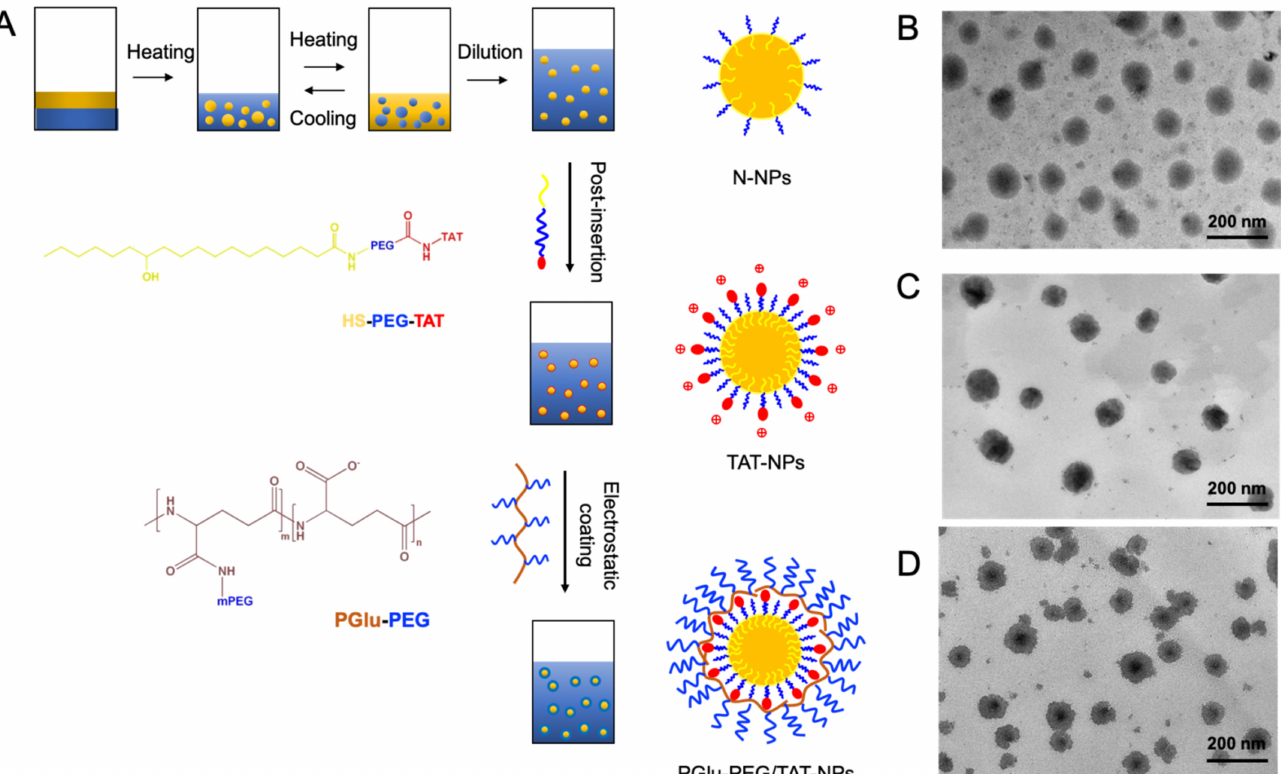
Figure 1. ( A ) Schematic illustration of preparation of DSF-loaded nanoparticles and corresponding structures. N-NPs were prepared by phase-inversion method. TAT-NPs were obtained by post-insertion of HS-PEG-TAT due to its lipophilicity of stearate. PGlu-PEG/TAT-NPs were manipulated by electrostatic absorption between -NH 3+ and -COO − . ( B – D ) TEM images of DSF-loaded N-NPs ( B ), TAT-NPs ( C ), and PGlu-PEG/TAT-NPs ( D ). Scale bars: N-NPs and TAT-NPs: 200 nm; PGlu-PEG/TAT-NPs: 500 nm. HS-PEG-TAT, 12-hydroxystearic-PEG16-TAT AYGRKKRRQRRR; PGlu-PEG, poly (glutamate acid)-graft-poly (ethylene glycol); N-NPs, DSF-loaded naked nanoparticles; TAT-NPs, DSF-loaded cationic nanoparticles;